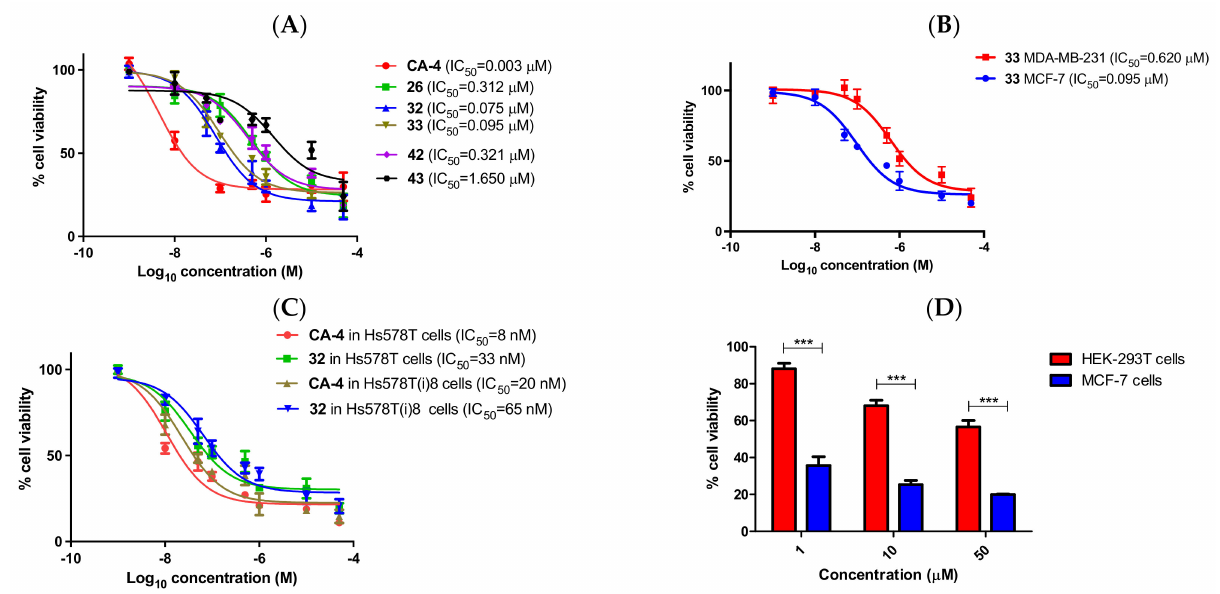
Figure 4. Antiproliferative activity of 3-fluoro β -lactams on MCF-7, MDA-MB-231, Hs578T and Hs578T isogenic subclone Hs578T(i)8 breast cancer cells and non-tumourigenic HEK-293T cells. ( A ) Antiproliferative activity for 3-fluoro β -lactams 26 , 32 , 33 , 42 and CA-4 in MCF-7 cells. Cells were grown in 96-well plates and treated with indicated β -lactam compounds at 0.01–50 µ M for 72 h. Cell viability was expressed as a percentage of vehicle control (ethanol 1% ( v / v ))-treated cells. The values represent the mean ± S.E.M. for three independent experiments performed in triplicate. ( B ) Antiproliferative activity of 3-fluoro β -lactam 33 in MCF-7 and MDA-MB-231 cells. ( C ) Antiproliferative activity of 3-fluoro β -lactam 33 in triple-negative breast cancer cell line Hs578T and its isogenic subclone Hs578T(i)8. ( D ) Effect of compound 33 on viability of MCF-7 and non- tumourigenic HEK-293T cells. Cells were grown in 96-well plates and treated with compound 33 at 1, 10 and 50 µ M for 72 h. Cell viability was expressed as a percentage of vehicle control (ethanol 1% ( v / v ))-treated cells and was measured by AlamarBlue assay (average of three independent experiments). Two-way ANOVA (Bonferroni post-test) was used to test for statistical significance (***, p <